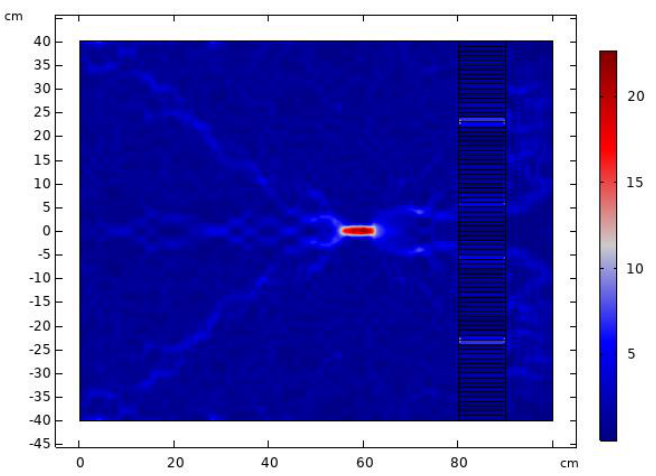
Figure 19. Spatial distribution of acoustic intensity field through focusing lens at 50 kHz.